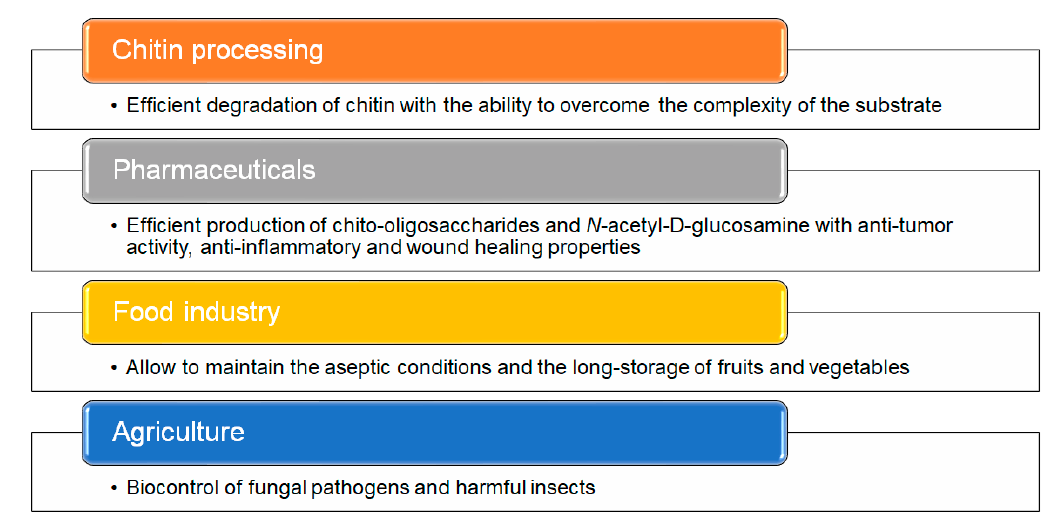
Figure 5. Applications of chitinases. The main applications of hyperthermophilic enzymes from different Archaea are summarized [107–110].